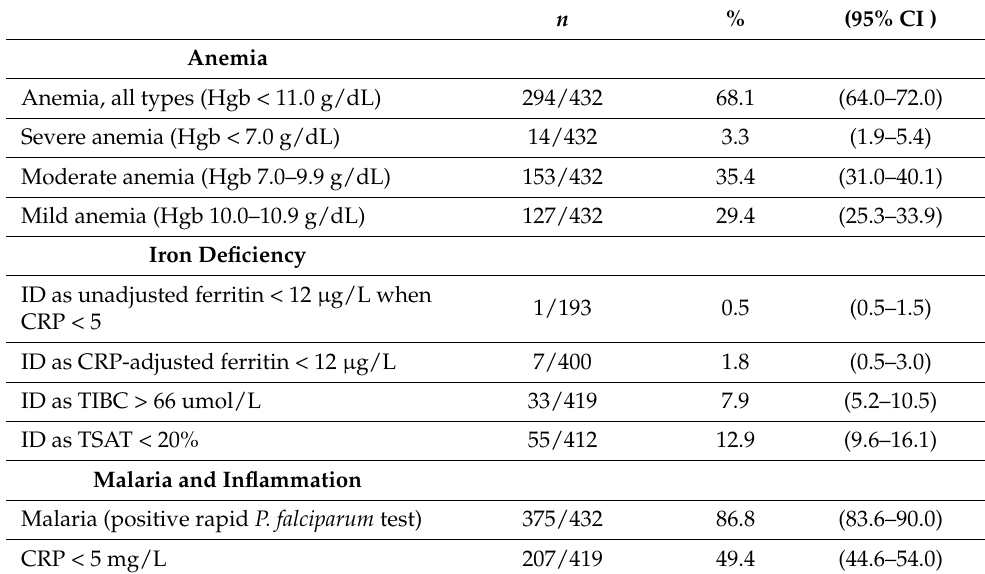
Table A3. Prevalence and distribution of anemia, iron deficiency, and malaria.